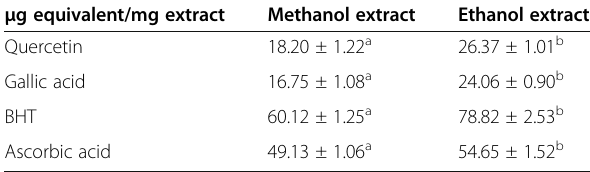
Table 3 Total phenols in methanol and ethanol extracts of E. crassipes . Amounts are represented in equivalence to other standard antioxidants containing phenolic group (except ascorbic acid)